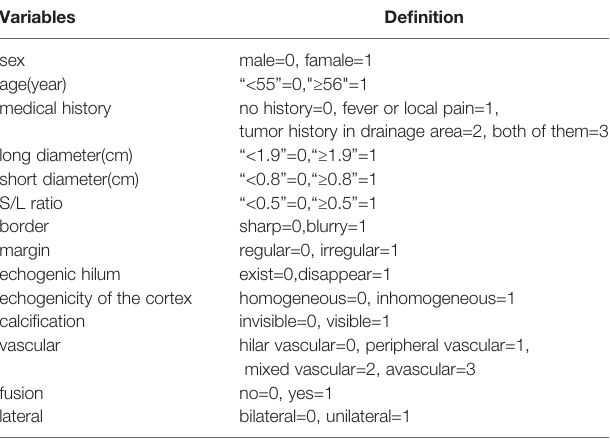
TABLE 3 | The de fi nition of variables in logistic